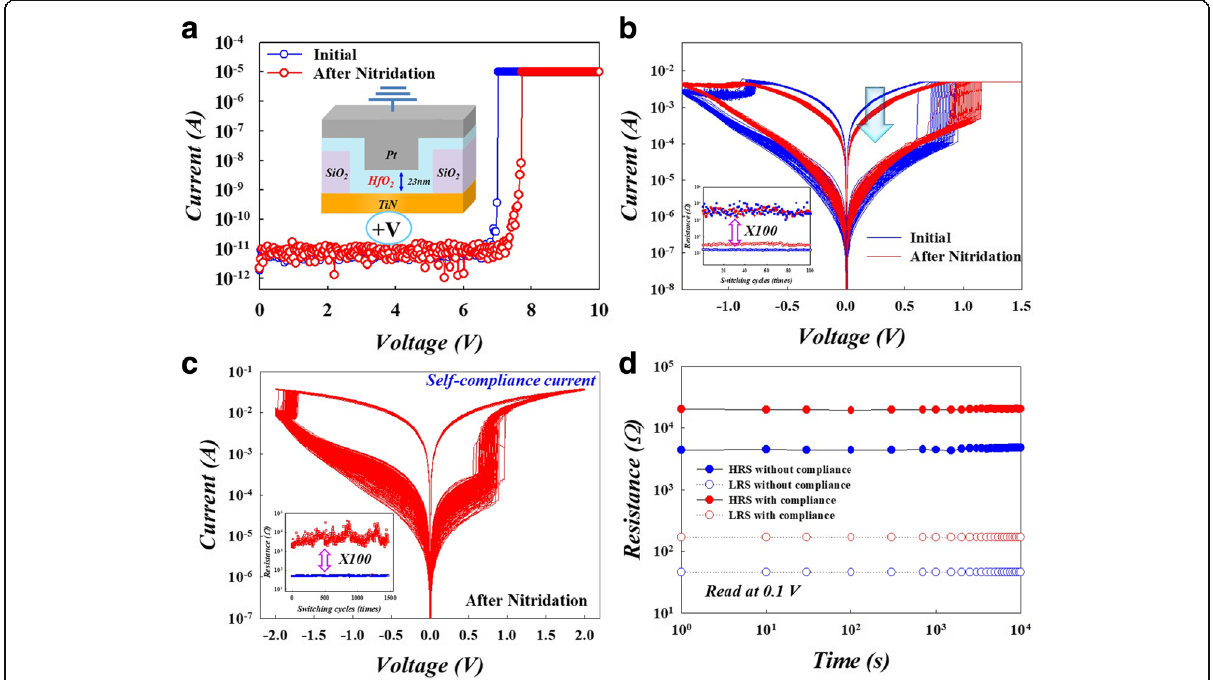
Fig. 1 a The forming current curves of HfO 2 -based RRAM devices. b Comparison of DC sweep cycles at a 5 mA compliance current between initial and after nitridation treatment of HfO 2 -based RRAM. c DC sweep cycles without external current compliance of the HfO 2 device after nitridation treatment. d Retention time of the HfO 2 -based RRAM devices at 85 °C with and without compliance current after nitridation